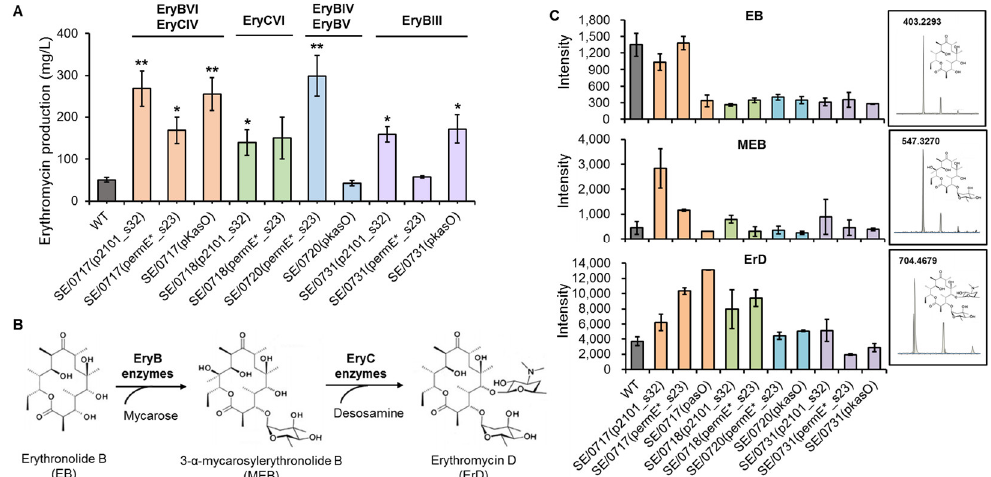
Figure 3. Erythromycin production analysis of engineered S. erythraea strains. ( A ) Total erythromycin production (ErA + ErB) of the wild-type strain S. erythraea NRRL 23338 (WT) and different engi- neered strains. The target enzymes of promoter engineering in each strain are indicated above the corresponding column. Error bars represent the standard deviation of three biological samples. * p ≤ 0.05 and ** p ≤ 0.01 (Student’ s two-tailed t -test). ( B ) Biosynthesis of the compounds related to EryB and EryC enzymes including erythronolide B (EB), 3-α-mycarosylerythronolide B (MEB) and eryth- romycin D (ErD). ( C ) Peak intensities of the intermediates EB, MEB, and ErD detected by MS in the fermentation extract of S. erythraea NRRL 23338 (WT) and engineered strains. The primary m/z value and MS spectrum of each compound are indicated in the box. Error bars indicate the standard de- viations of three biological replicates.